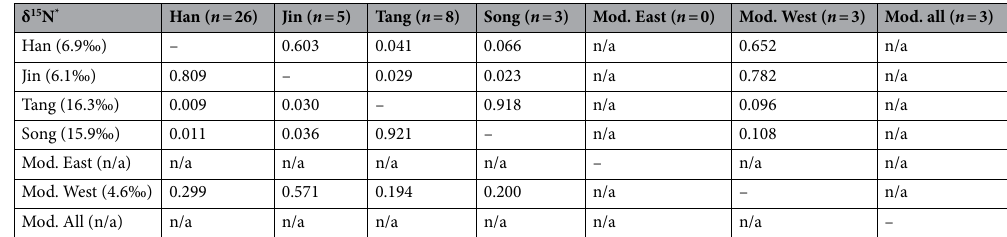
Table 3. Student’s t-test (top/right) and Mann–Whitney U test (bottom/left) p -value results for bulk δ 15 N from ancient and modern Phragmites . *Mean reported as ‰ vs.